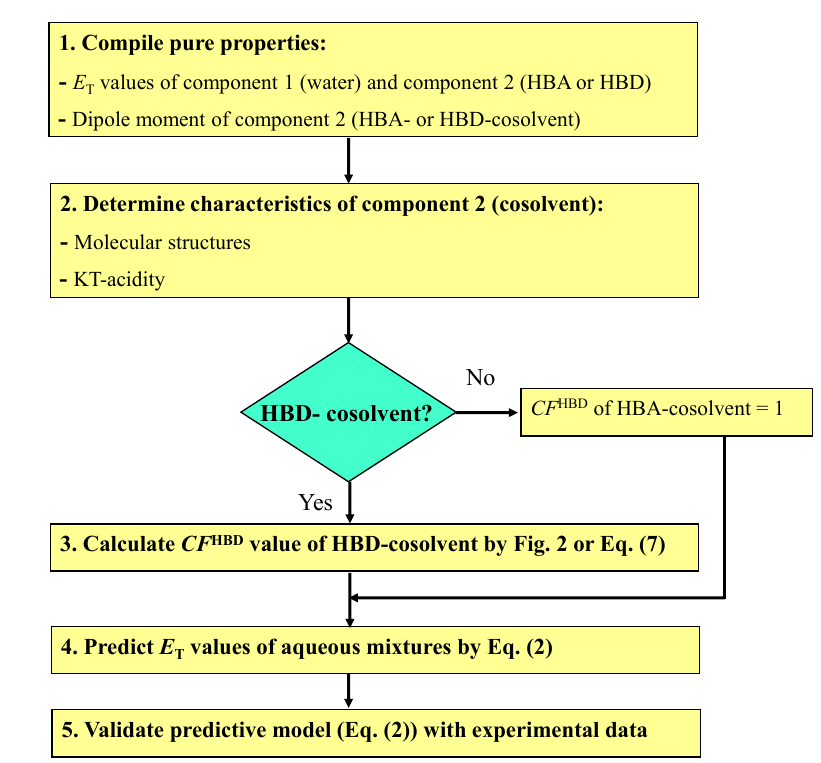
Figure 4. Flow chart for predicting electronic transition ( E T ) of aqueous mixture with five steps. Table 2. Comparison between electronic transition ( E T , kcal · mol − 1 ) values calculated with the predictive model (Equation (2)) and ideal model (Equation (1)) for nine aqueous mixtures of hydrogen bond acceptor (HBA) cosolvents and nine aqueous mixtures of hydrogen bond donor (HBD) cosolvents at 25 ◦ C that were obtained with Reichardt indicator. Average relative deviations (ARD) were calculated with Equation (8) along with dipole moment of component 2 ( µ 2 ), HBD contribution factor ( CF HBD ), Hunter basicity ( β H ) of component 2, pure properties of electronic transition energy ( E 0 ) and the number of data used (N). Gray-shaded rows indicate the ARD results estimated from the calculated CF HBD (Equation (7)).